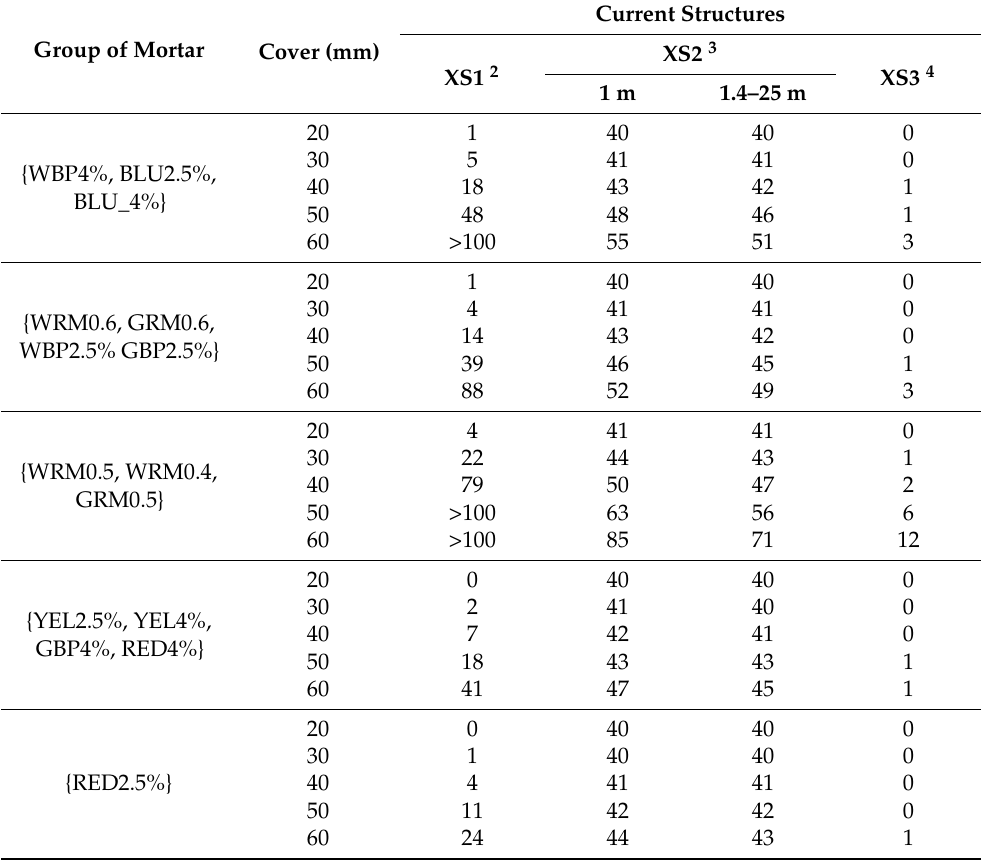
Table 7. Prediction of service life, t g , exposure classes XS 1 .